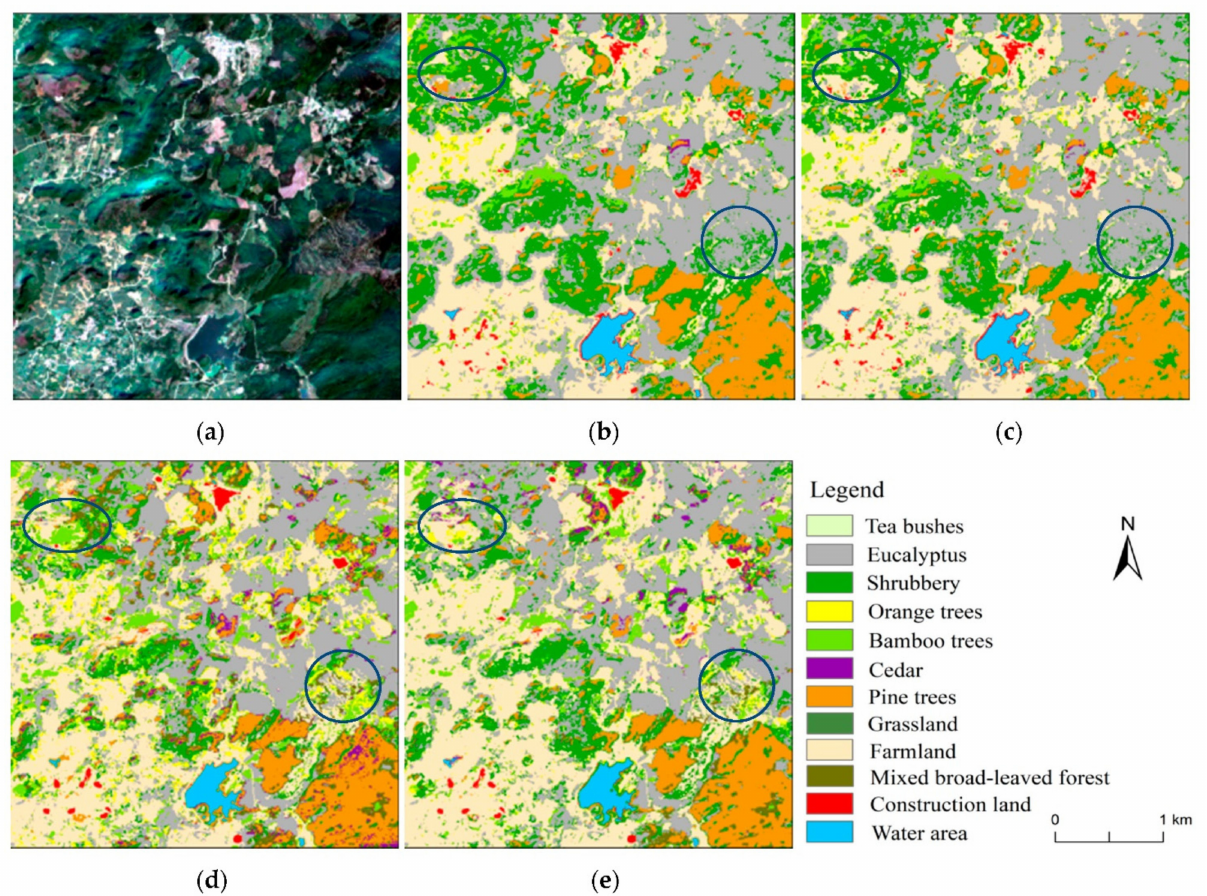
Figure 9. Local classification results of the different classification methods: ( a ) original image; ( b ) RF; ( c ) GTB; ( d ) SVM; ( e )